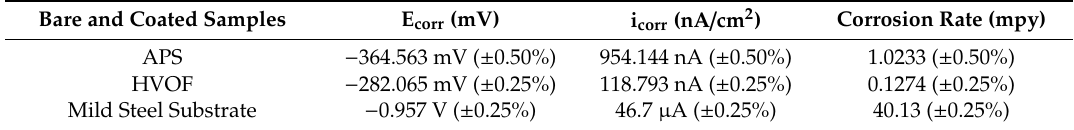
Figure 3. Corrosion analysis. ( a ) Potentiodynamic polarization curves. ( b ) Comparison of corrosion Figure3. Corrosionanalysis. ( a )Potentiodynamicpolarizationcurves. ( b )Comparisonofcorrosionrate. rate. Table 3. Potentiodynamic